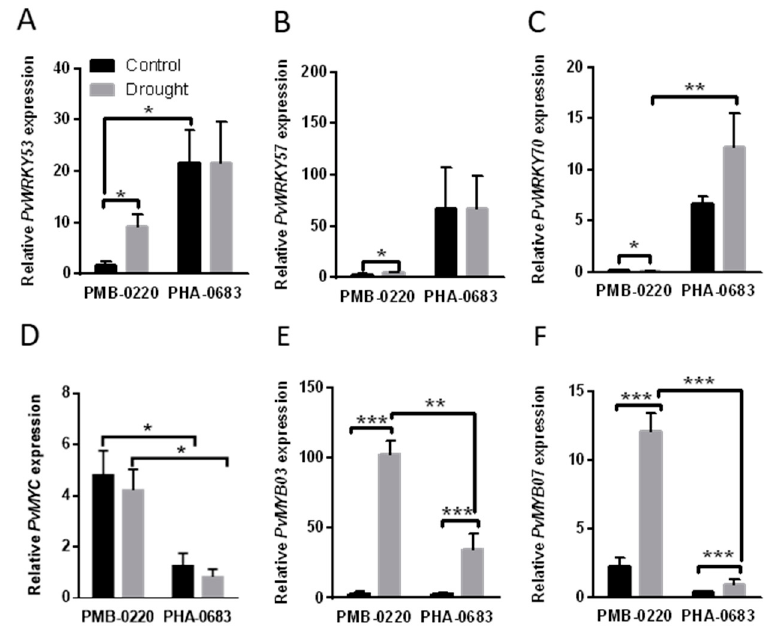
Figure 4. Relative expression of key transcription factors related with senescence and drought responses in leaves from control and 10 days-drought-stressed PMB-0220 and PHA-0683 plants, grown under symbiotic nitrogen fixation conditions. Relative expression of ( A ) PvWRKY53 ; ( B ) PvWRKY57 ; ( C ) PvWRKY70 ; ( D ) PvMYC ; ( E ) PvMYB03 ; and ( F ) PvMYB07 in response to drought. Data are means of three independent experiments and asterisks indicate statistically significant differences (* p < 0.05) (** p < 0.005) and (*** p < 0.0005).